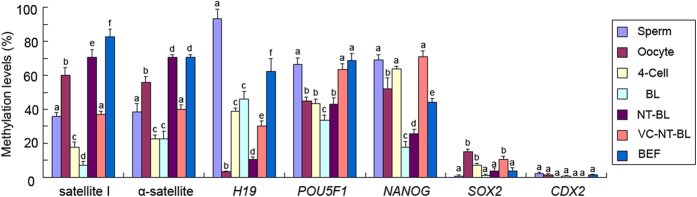
A diagram showing the differences in methylation levels of seven genes in bovine sperm, oocytes, IVF 4-cell embryos, IVF blastocysts, SCNT blastocysts, SCNT blastocysts treated with vitamin C and BEFs.The results represent the mean ± standard deviation of three independent experiments in which at least fifty cells or blastomeres were analyzed. For each gene, different lowercase letters denote a significant difference (P < 0.05), and the same letter represents no significant difference (P > 0.05). 4-cell: IVF 4-cell; BL: IVF blastocyst; NT-BL: SCNT blastocyst; VC-NT-BL: SCNT blastocyst treated with vitamin C; and BEF: bovine embryonic fibroblasts.